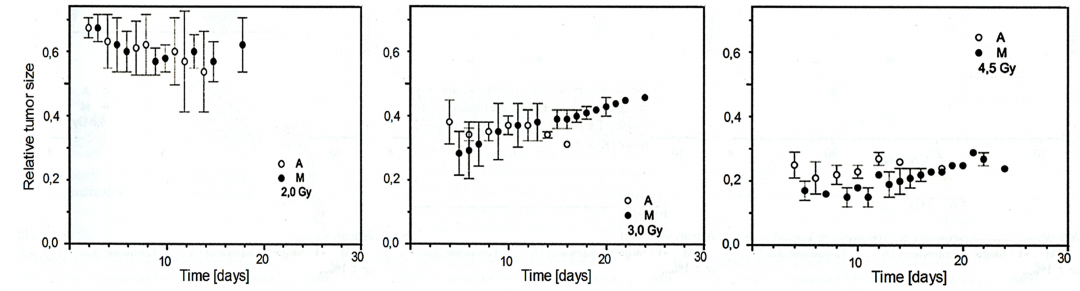
Figure 4. No difference in radiosensitivity between Ab and Ma cells treated with neutrons [130]. Copyright 2000 Urbanska,